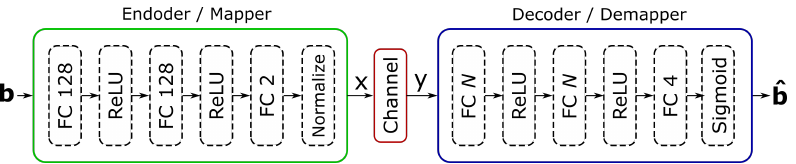
Figure 2. Overview of the AE ANN